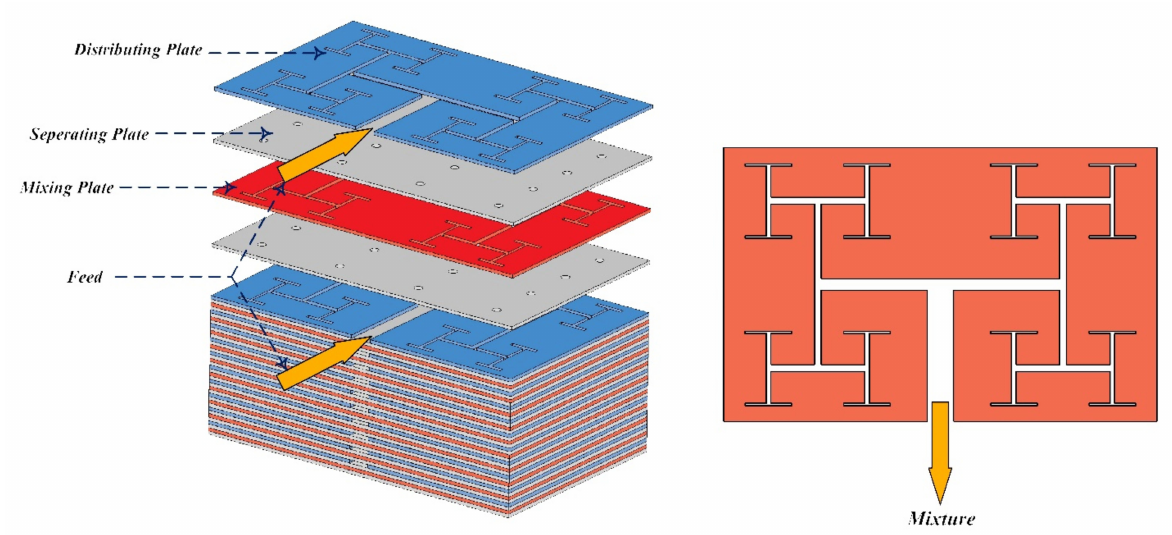
Figure 28. The construct tree-shaped configuration for a micromixer